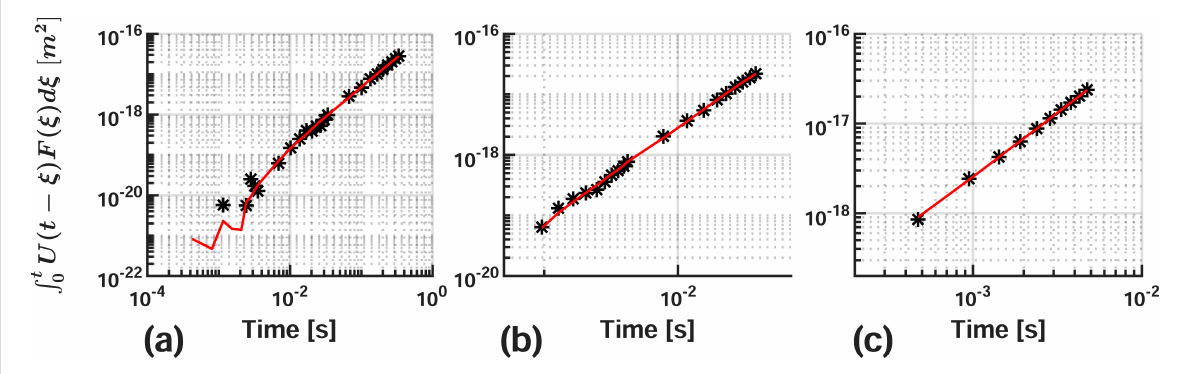
Figure 6: AFM-SFS data and parameterized generalized-Voigt mechanical model. Data and nonlinear least-squares fit for (a) 10 nm/s, (b) 100 nm/s, and (c) 1000 nm/s. The parameters utilized in each case have been marked in Table 2 with an asterisk (*). The results are comparable to those noted by Lopez and co-workers [17].